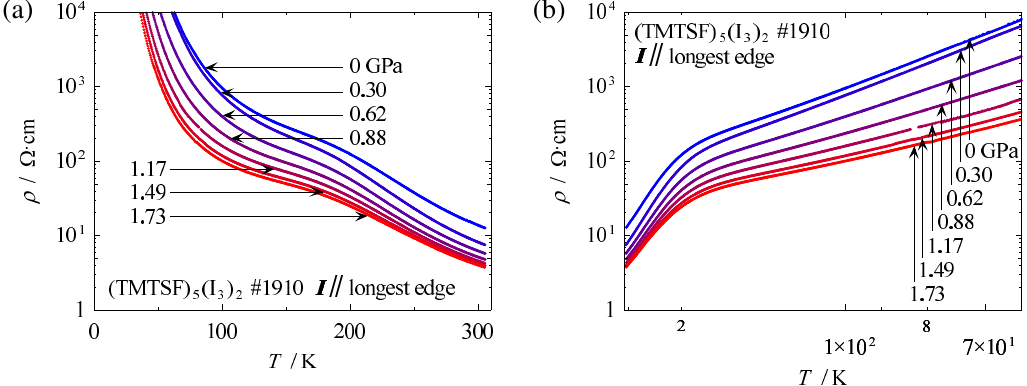
Figure 7. ( a ) Temperature dependence of the electrical resistivity ρ of (TMTSF) 5 (I 3 ) 2 measured along the longest crystal edges. ( b ) Arrhenius plot of the same data in ( a ). Please note that the values in the horizontal axis is T but the scale is linear in T − 1